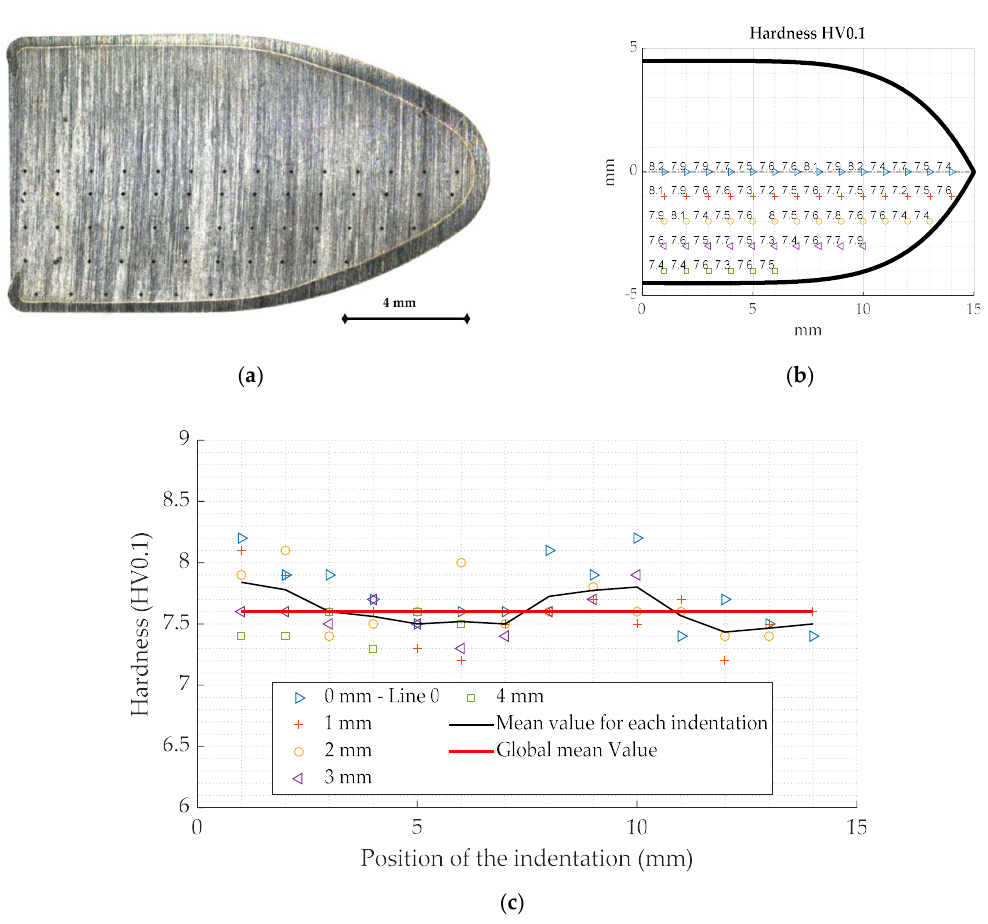
Figure 2. ( a ) Longitudinal section of the 9 mm ammunition with the indentation points; ( b ) hardness mapping in the longitudinal side of the ammunition (HV0.1); ( c ) hardness for the different indentation and average.